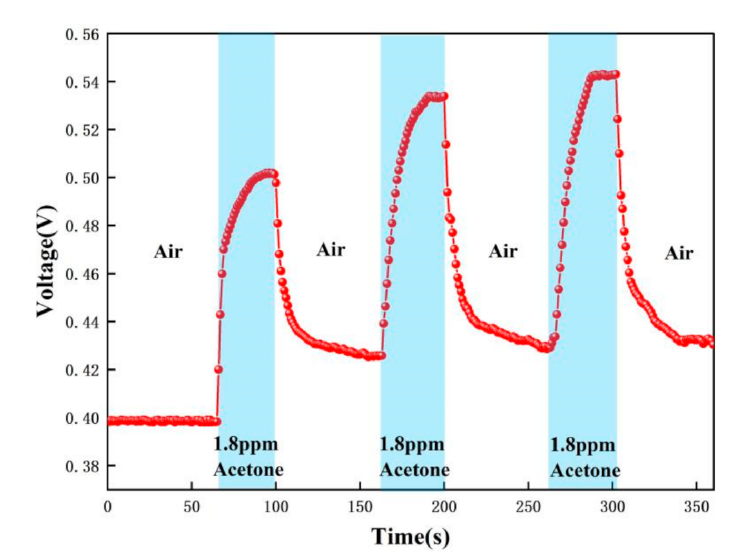
Figure 15. Test result of 1.8 ppm acetone.